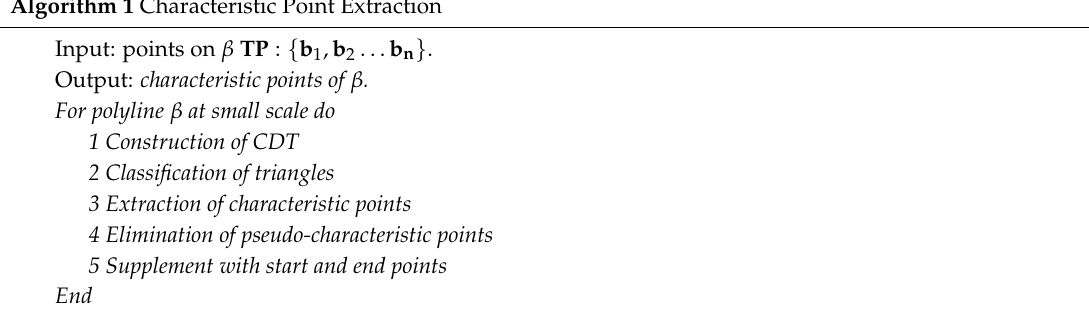
Algorithm 1 Characteristic Point